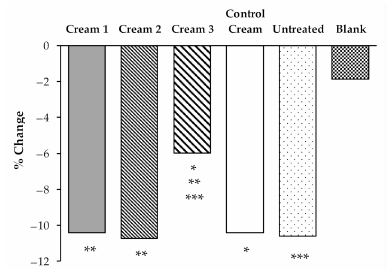
Figure 6. Effects of the application of the different creams on b*parameter changes before and after UVA irradiation. Mean values of all volunteers ( n = 10). Untreated, was used as a control and a blank skin area was also used as a negative control. The statistical comparison between products and controls is also shown (*, **, ***: p <